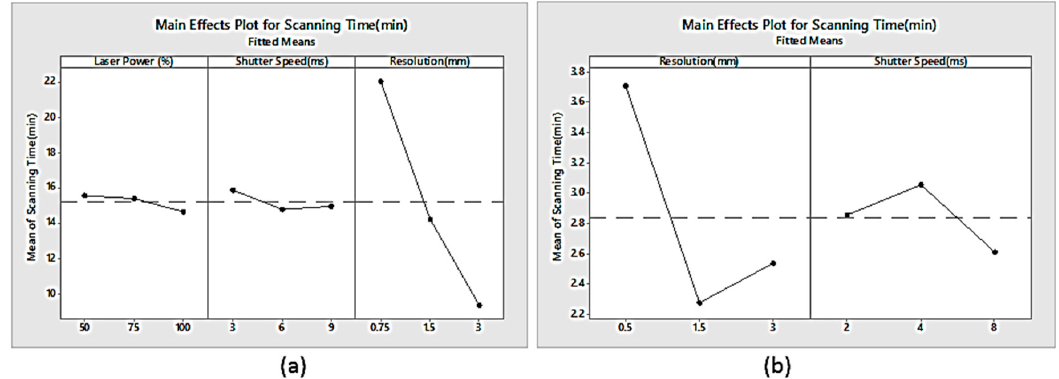
Figure 14. Main effect plots for deviation: ( a ) laser scanner; ( b ) white light scanner.